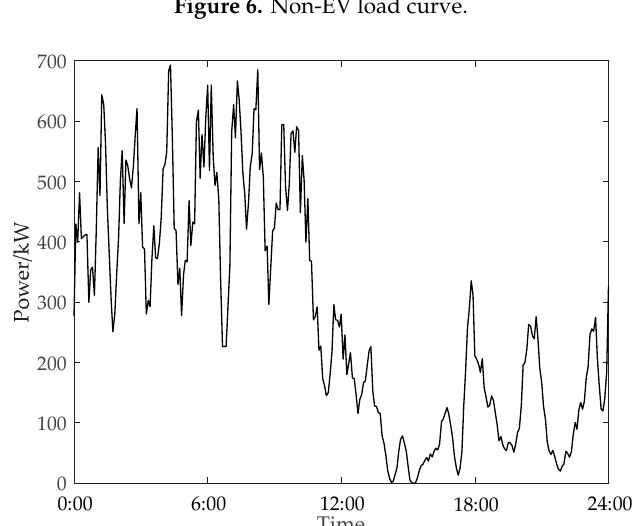
Figure 6. Non-EV load curve.